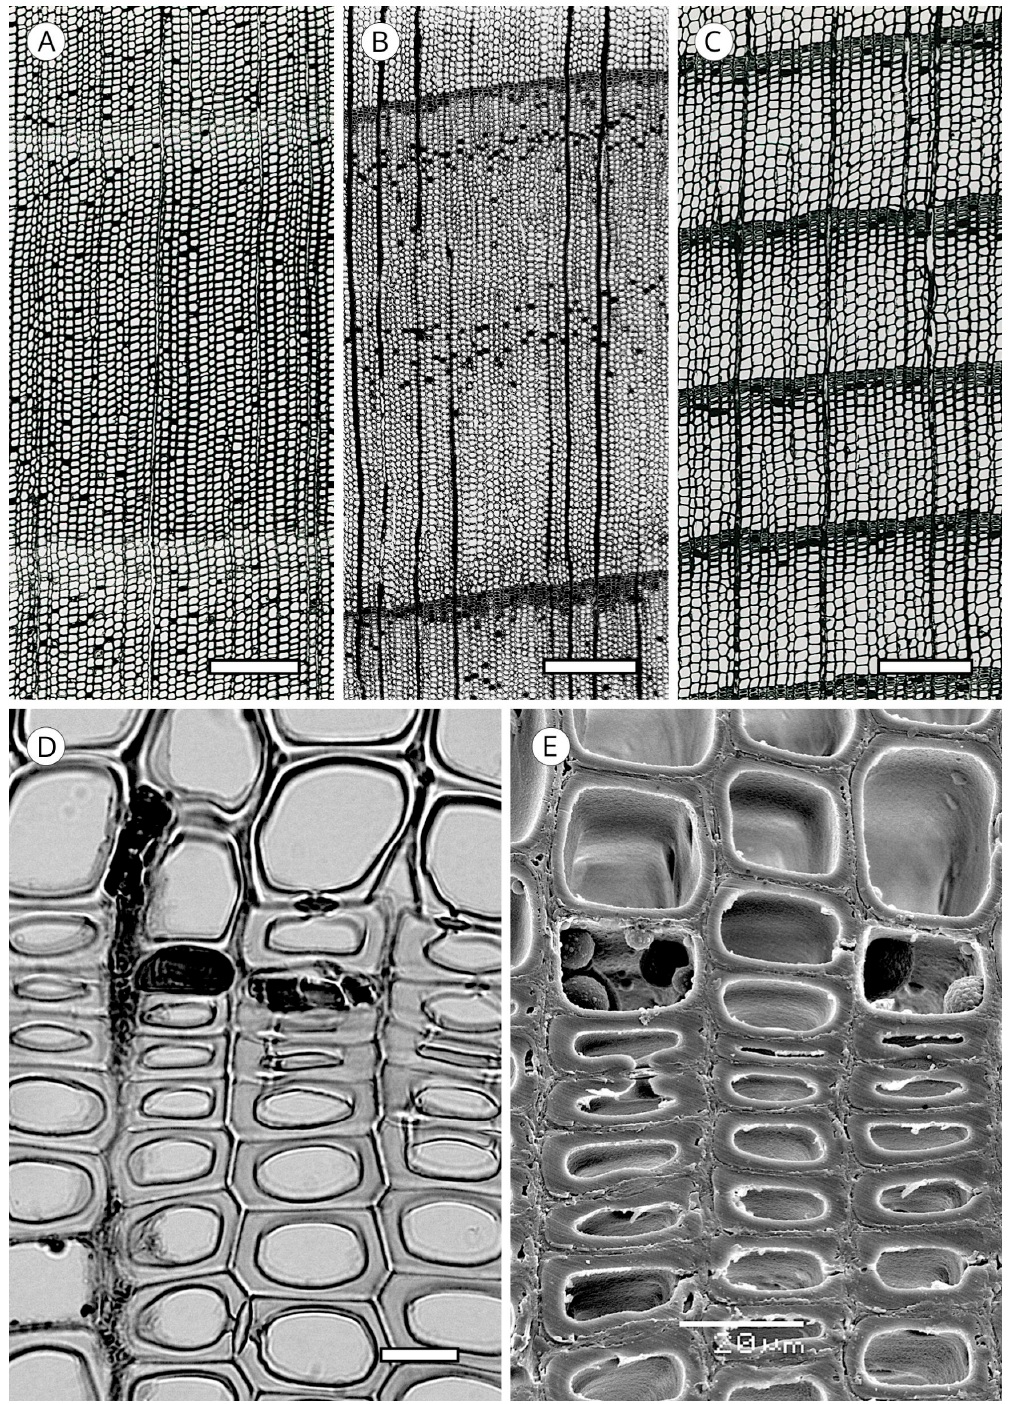
Figure 26. Arrangement of axial parenchyma. ( A ) Diffuse in Dacrydium elatum (Roxb.) Wall. ex Hook.; ( B ) Tangentially zonate in Juniperus excelsa M.Bieb. ; ( C ) Marginal in Fitzroya cupressoides (Molina) I.M.Johnst.; ( D ) Marginal in Hesperocyparis macrocarpa (Hartw.) Bartel (Syn.— Cupressus macrocarpa Hartw.); ( E ) Marginal in Juniperus chinensis L. (SEM). Scale bars. ( A ) = 350 μ m; ( B ) = 600 μ m; ( C ) = 400 μ m; ( D ) = 25 μ m.